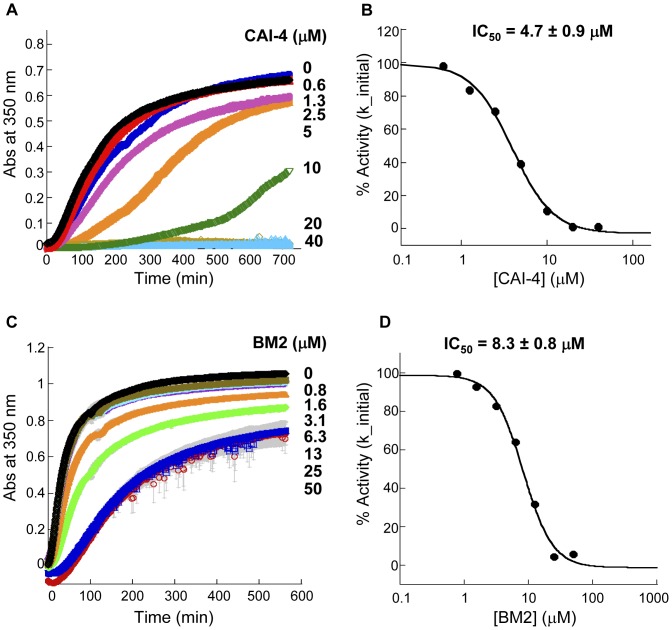
Inhibition of full-length wild-type capsid polymerization kinetics by two CA binding agents.(A, B) CAI-4 is a peptide that binds to the C-terminal domain of CA. (C, D) BM2 is a small molecule inhibitor described by Boehringer Ingelheim that binds to the CA N-terminal domain. WT CA was pre-incubated with each inhibitor. Assembly reactions were induced by 2-fold dilution of capsid protein into buffer containing 50 mM sodium phosphate pH 7.5, 4 M NaCl at 25°C. The increase of turbidity (absorbance at 350 nm) of 40 µM solution of WT CA in the presence of increasing concentrations of inhibitor (depicted on the right side of kinetic traces) was plotted as a function of time. The data points represent an average of three determinations with standard deviation shown as grey bars. The dose response curves of inhibition of polymerization kinetics and the concentration of inhibitor resulting in a half-maximal inhibition (IC50) for (B) CAI-4 and (D) BM2. The percent of inhibitor activity (% Activity) represents the percent of decrease of the initial rate of polymerization reaction.